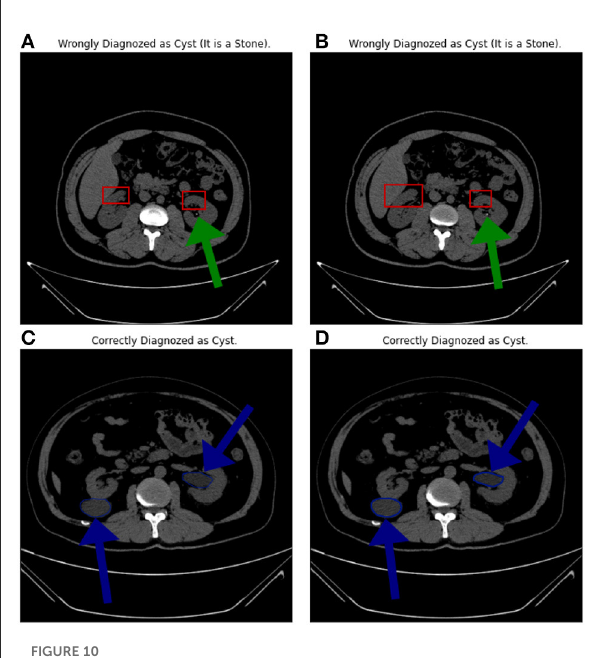
FIGURE10 (A–D) Samples from the misclassified